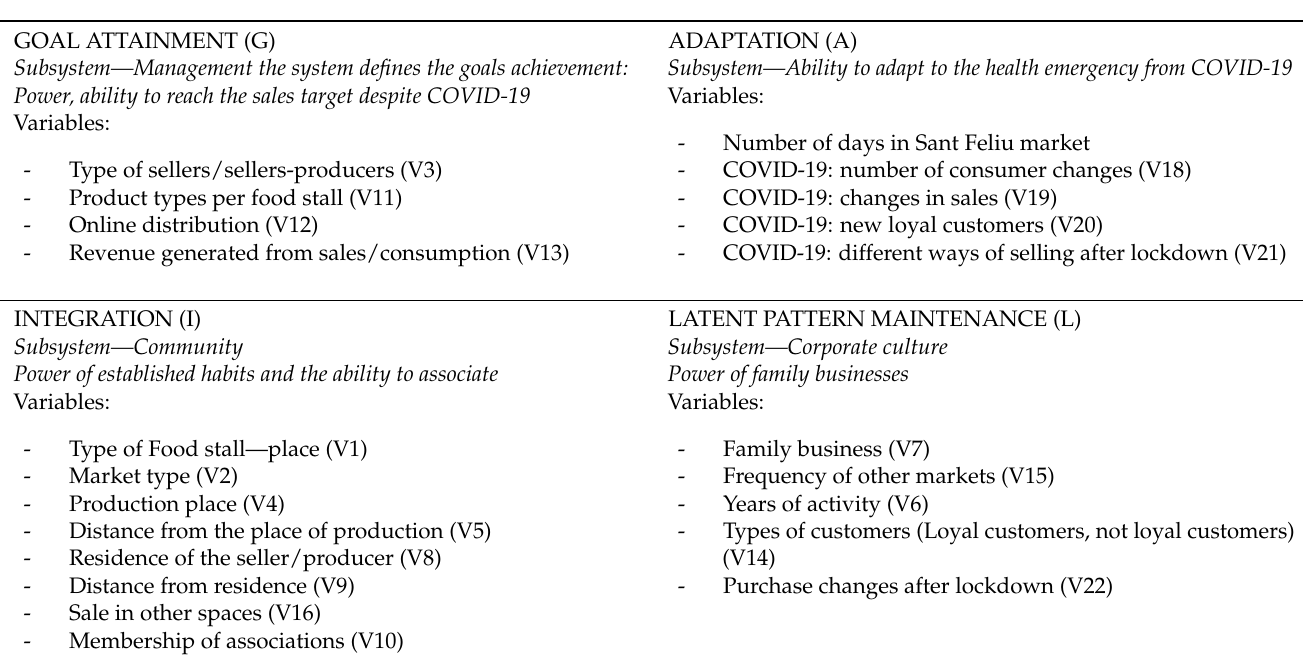
Table 4. AGIL scheme model of adaptation of the sellers/producer—sellers of the San Feliu mar- ket to the health crisis arising from COVID-19. For each quadrant, the subsystem and variables are